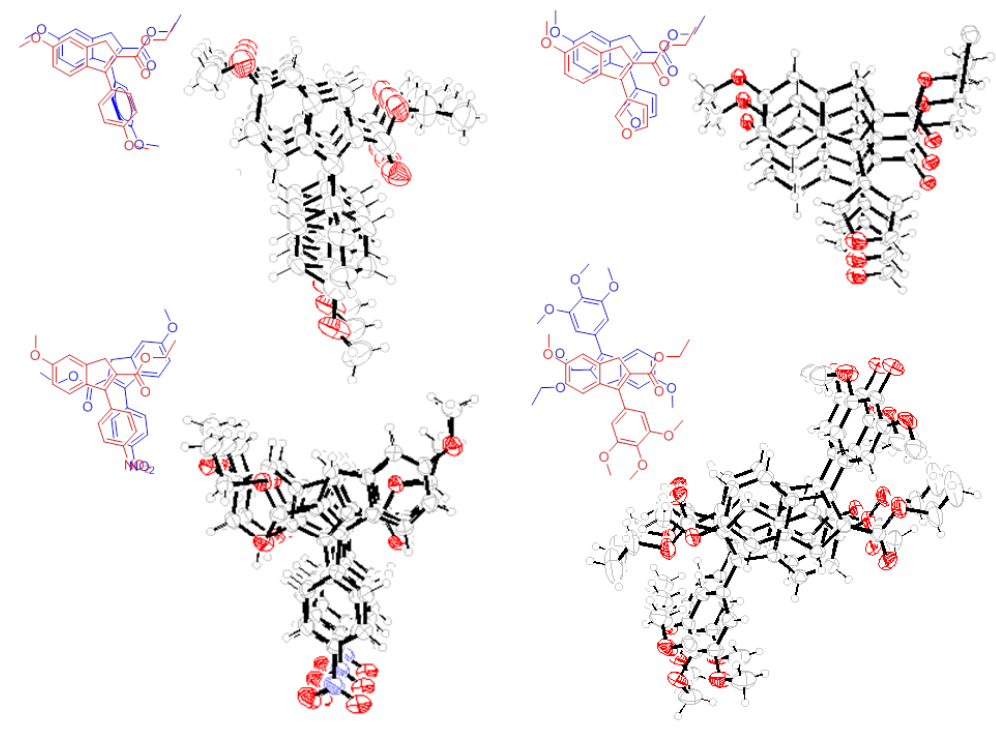
Figure 7. Crystal packing of indene derivatives 6c ( top left ), 6h ( top right ), 6f ( bottom left ), and 6e ( bottom right ).